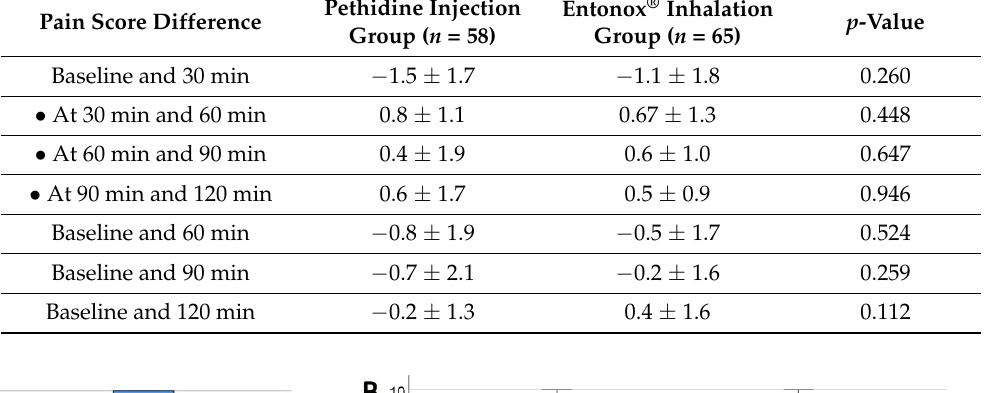
Table 3. Mean difference of pain score in pethidine injection group and Entonox ® inhalation group. Figure 1. Flow diagram showing enrollment and randomization of the study. Pain Score Difference